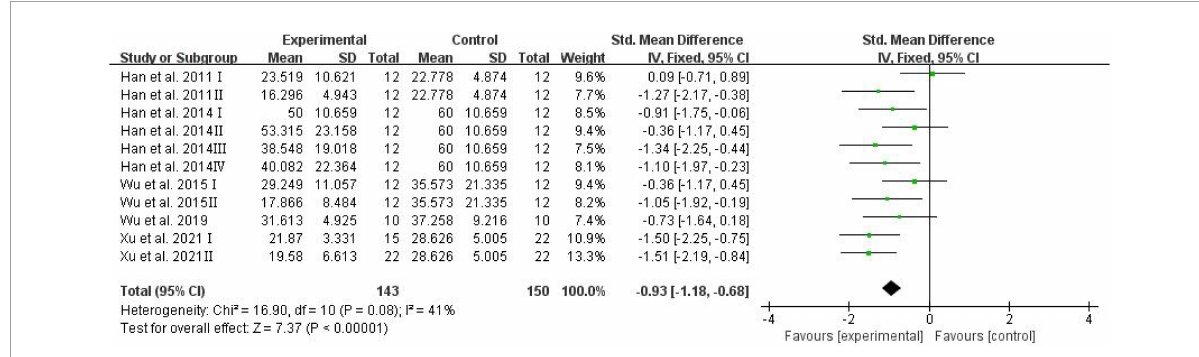
FIGURE4 Forest plot of the percentage of time in target quadrant in the Morris water maze test.